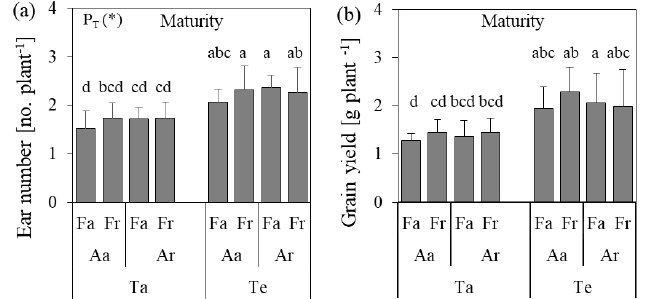
Fig. 6: Effects of soil temperature (T a , ambient; T e , elevated), precipitation amount (A a , ambient; A r , reduced), and precipitation frequency (F a , ambient; F r , reduced) on (a) ear number per plant and (b) grain yield per plant. Measurements were performed at plant maturity. Means and SDs are shown, asterisk indicates significance (*P ≤ 0.05, tested by three-way ANOVA applied to a mixed-effects model); n = 4. Dif- ferent letters indicate significant differences between treatments (LSD test, P ≤ 0.05).